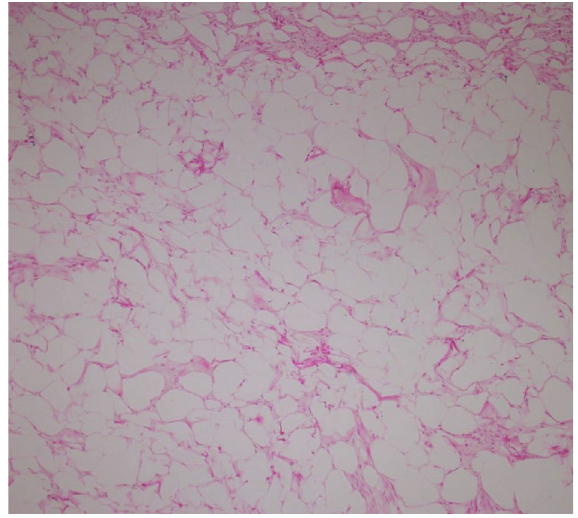
Figure 2: Mature white adipose tissue with bundles of smooth muscle at periphery ( × 40,